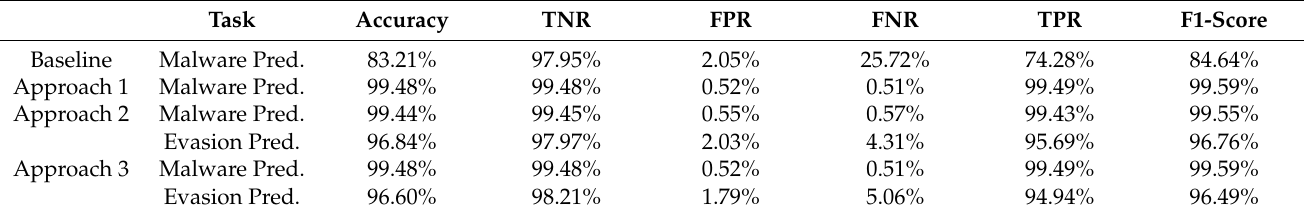
Table 6. Results of Experiments 0, 1, 2 and 3.